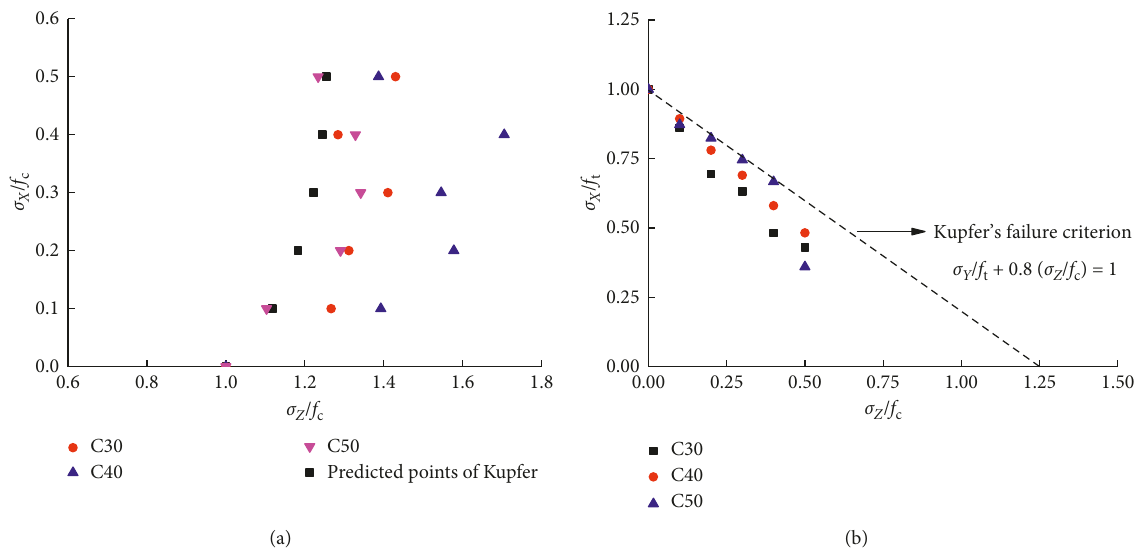
Figure 8: Comparison of Kupfer’s failure criterion and experimental data. (a) Biaxial compression-compression. (b) Biaxial compression-